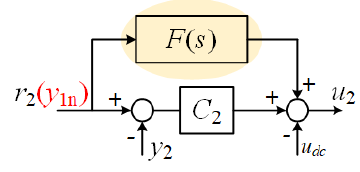
Figure 7. Structure of feed-forward